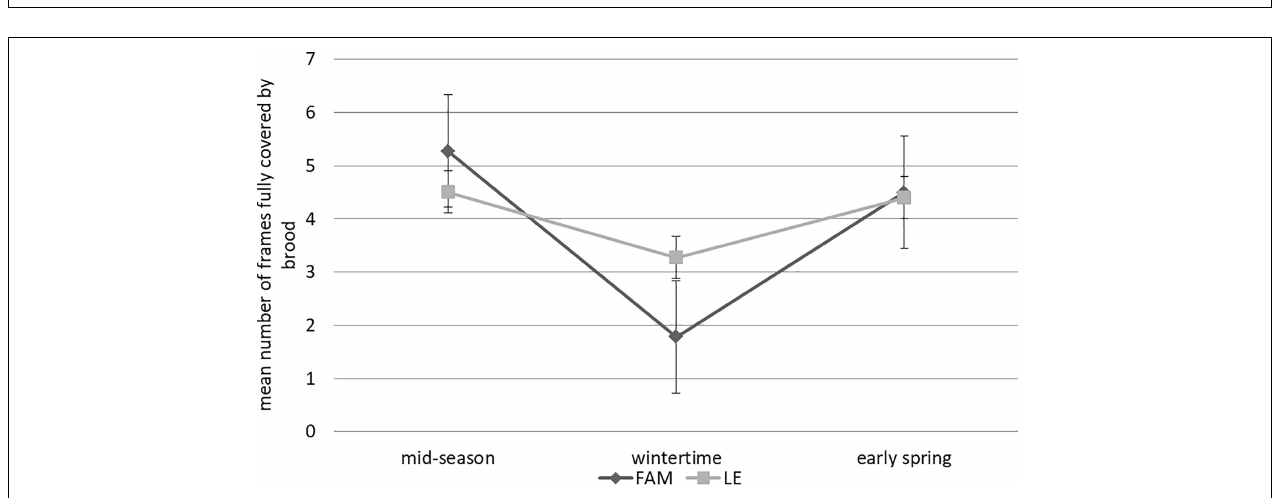
FIGURE 3 | Colony strength of A. mellifera colonies from Leales (LE) and Famaillá (FAM) apiaries during the beekeeping season (mid-season, wintertime and early spring). Mean percentage ( ± SE) of colonies in category 1 or 2 and percentage of lost colonies are shown.